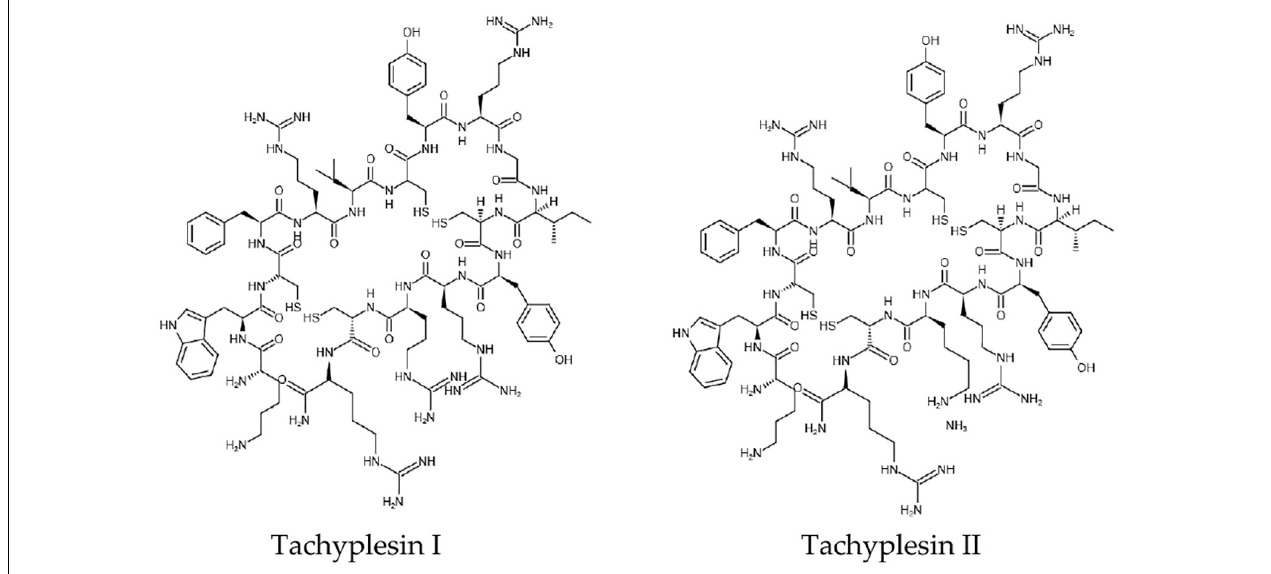
FIGURE 1 | The chemical structures of Tachyplesin I and Tachyplesin